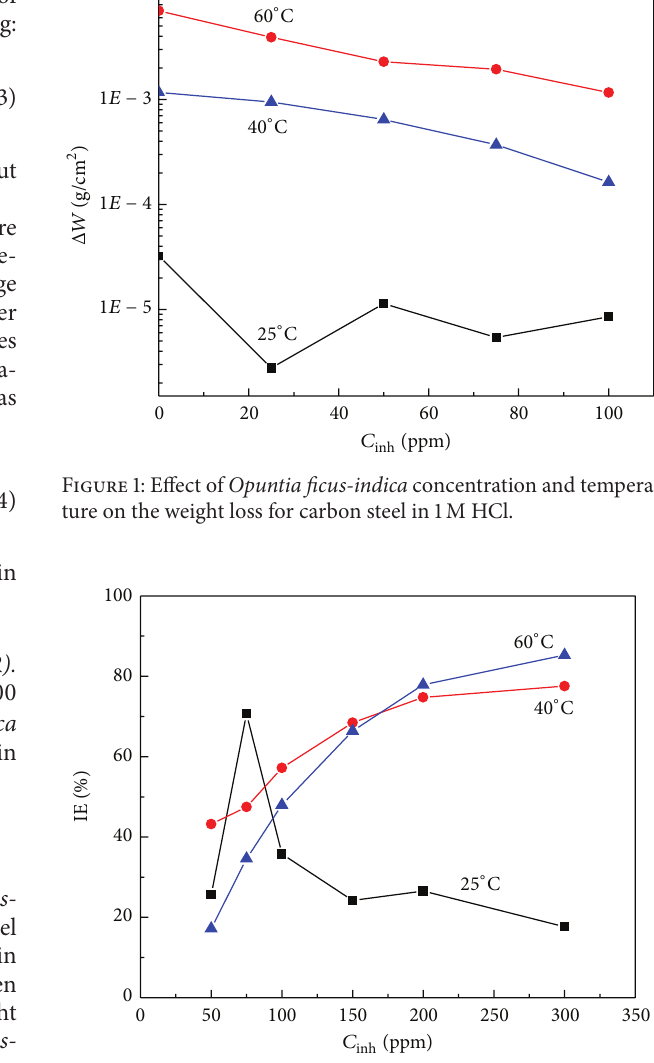
Figure 2: Effect of Opuntia ficus-indica concentration and temper- ature on the inhibitor efficiency value for carbon steel in 1M